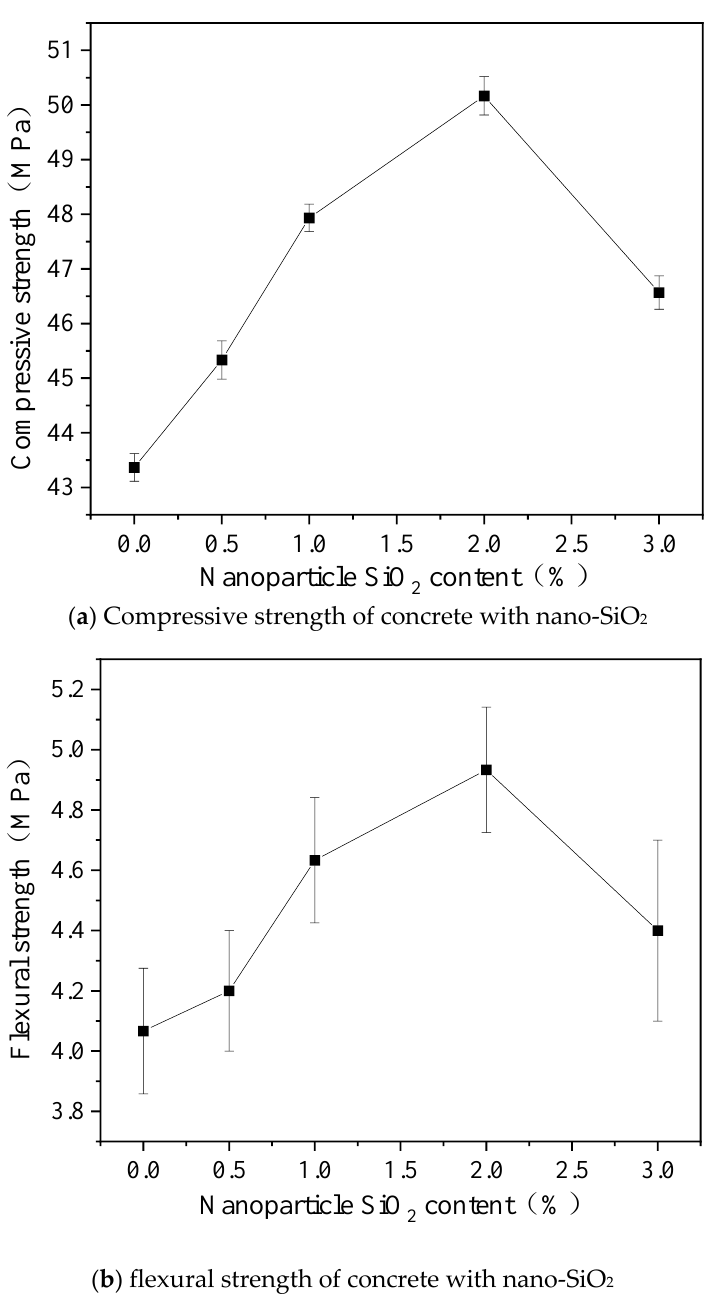
Figure 3. Compressive strength and flexural strength of concrete with nano-SiO 2 .